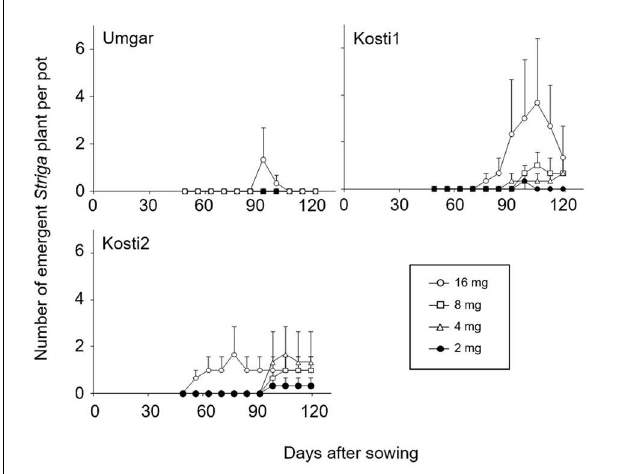
FIGURE 4 | Number of emergent S. hermonthica plants per pots planted with rice. Umgar, Kosti1, and Kosti2 were used in the first pot experiment. The Striga seeds (2, 4, 8, and 16 mg) were mixed into top 5 cm of soil in each pot. Bars indicate standard errors of each mean value of three replications.